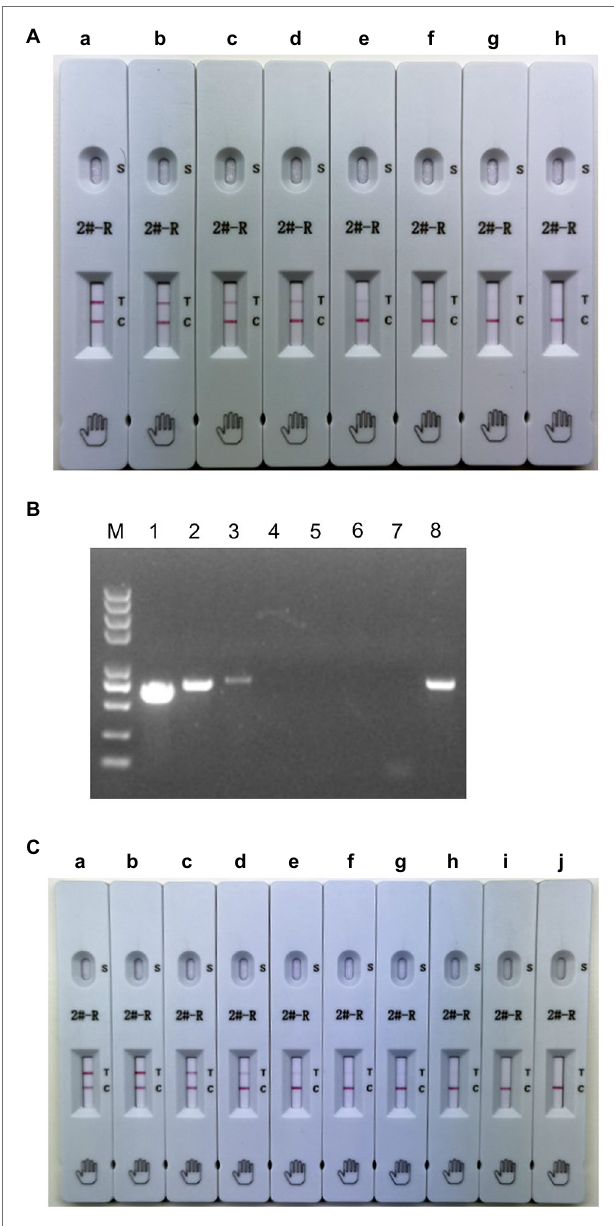
FIGURE 5 | Testing of the sensitivity of the ICS. Serial dilutions of PRRSV HuN4 (10 6.0 TCID 50 /ml; A,B ) and recombinant SDHS53-N protein (240 μ g/ml; C ) were prepared in sample dilution buffer and tested using the ICS assay developed in this study and PCR. In (A) , the tested virus dilutions were (A) 10 5 TCID 50 /ml, (B) 10 4.0 TCID 50 /ml, (C) 5 × 10 3.0 TCID 50 /ml, (D) 2.5 × 10 3.0 TCID 50 /ml, (E) 10 3.0 TCID 50 /ml, (F) 5 × 10 2.0 TCID 50 /ml, (G) 2.5 × 10 2.0 TCID 50 /ml, and (H) PBST. In (B) , the tested virus dilutions were (1) 10 5.0 TCID 50 /ml, (2) 10 4.0 TCID 50 /ml, (3) 10 3.0 TCID 50 /ml, (4) 10 2.0 TCID 50 /ml, (5) 10 TCID 50 /ml, (6) 1 TCID 50 /ml, (7) DMEM, and (8) positive control. In (C) , the tested dilutions of recombinant N protein were (A) 24,000 ng/ml, (B) 2,400 ng/ml, (C) 240 ng/ml, (D) 120 ng/ml, (E) 60 ng/ml, (F) 30 ng/ml, (G) 15 ng/ml, (H) 7.5 ng/ml, (I) 3.75 ng/ml, and (J)